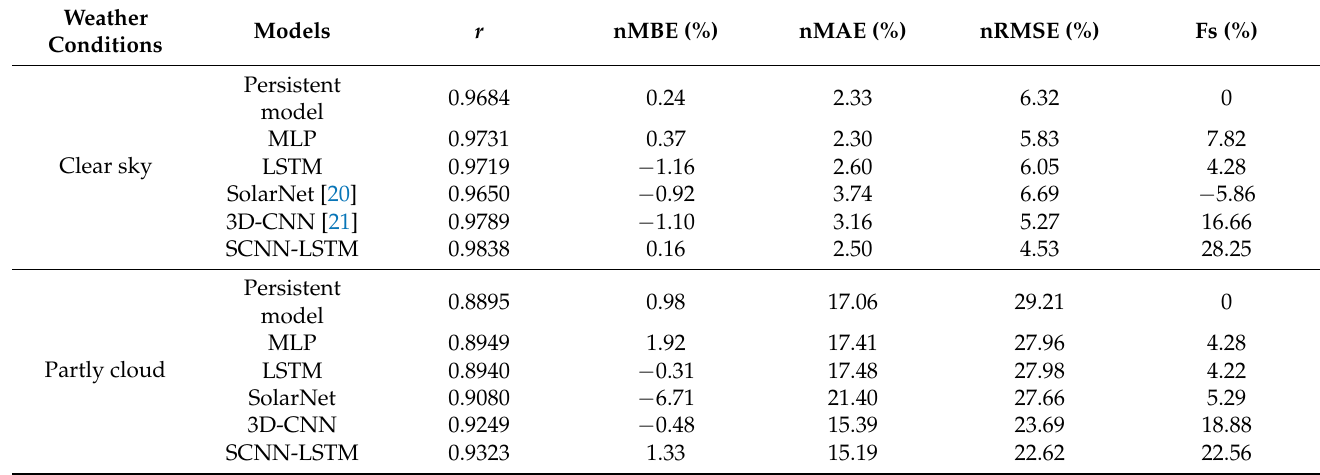
Table 6. The performance of different models for predicting the DNI 10-min in advance under different weather conditions. Weather Conditions